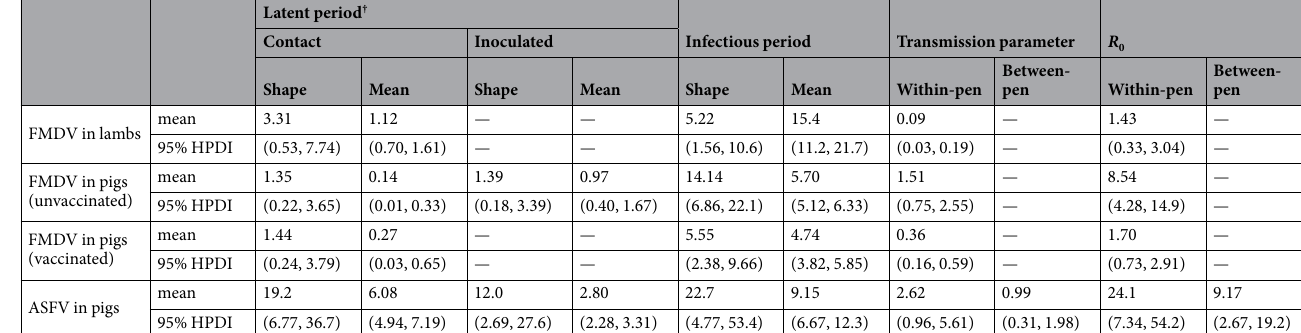
Table 1. Posterior median and 95% highest-posterior density intervals (HPDI) for gamma-distributed latent and infectious period parameters, transmission parameter and basic reproduction number for three transmission experiments. † For FMDV in lambs there was no significant difference in latent period between inoculated and contact-infected animals.